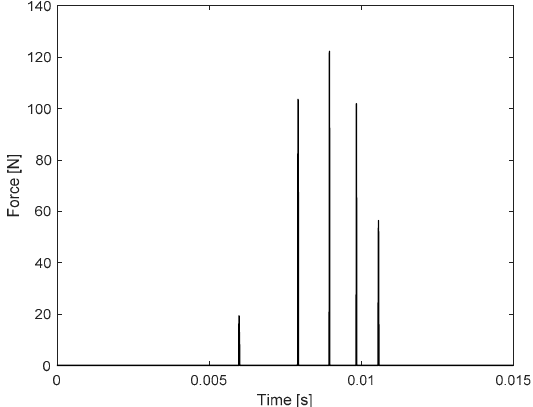
Figure 13. The impact forces by FE explicit analysis.